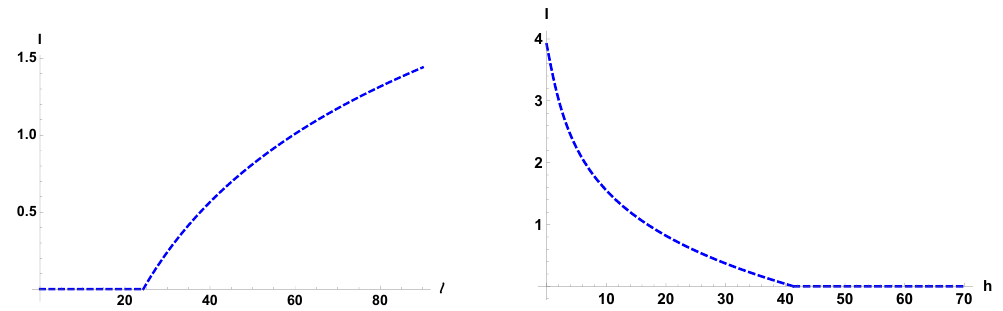
Figure 10 . HMI for d e = 1 : Left ) as a function of ‘ for r c = 1 and h = 10 . Right ) as a function of h for r = 1 and ‘ = 100 . HMI shows a first-order phase transition at the point h c depends on the cutoff r . Here we set R = 1 and renormalized I as ˜ I = I c